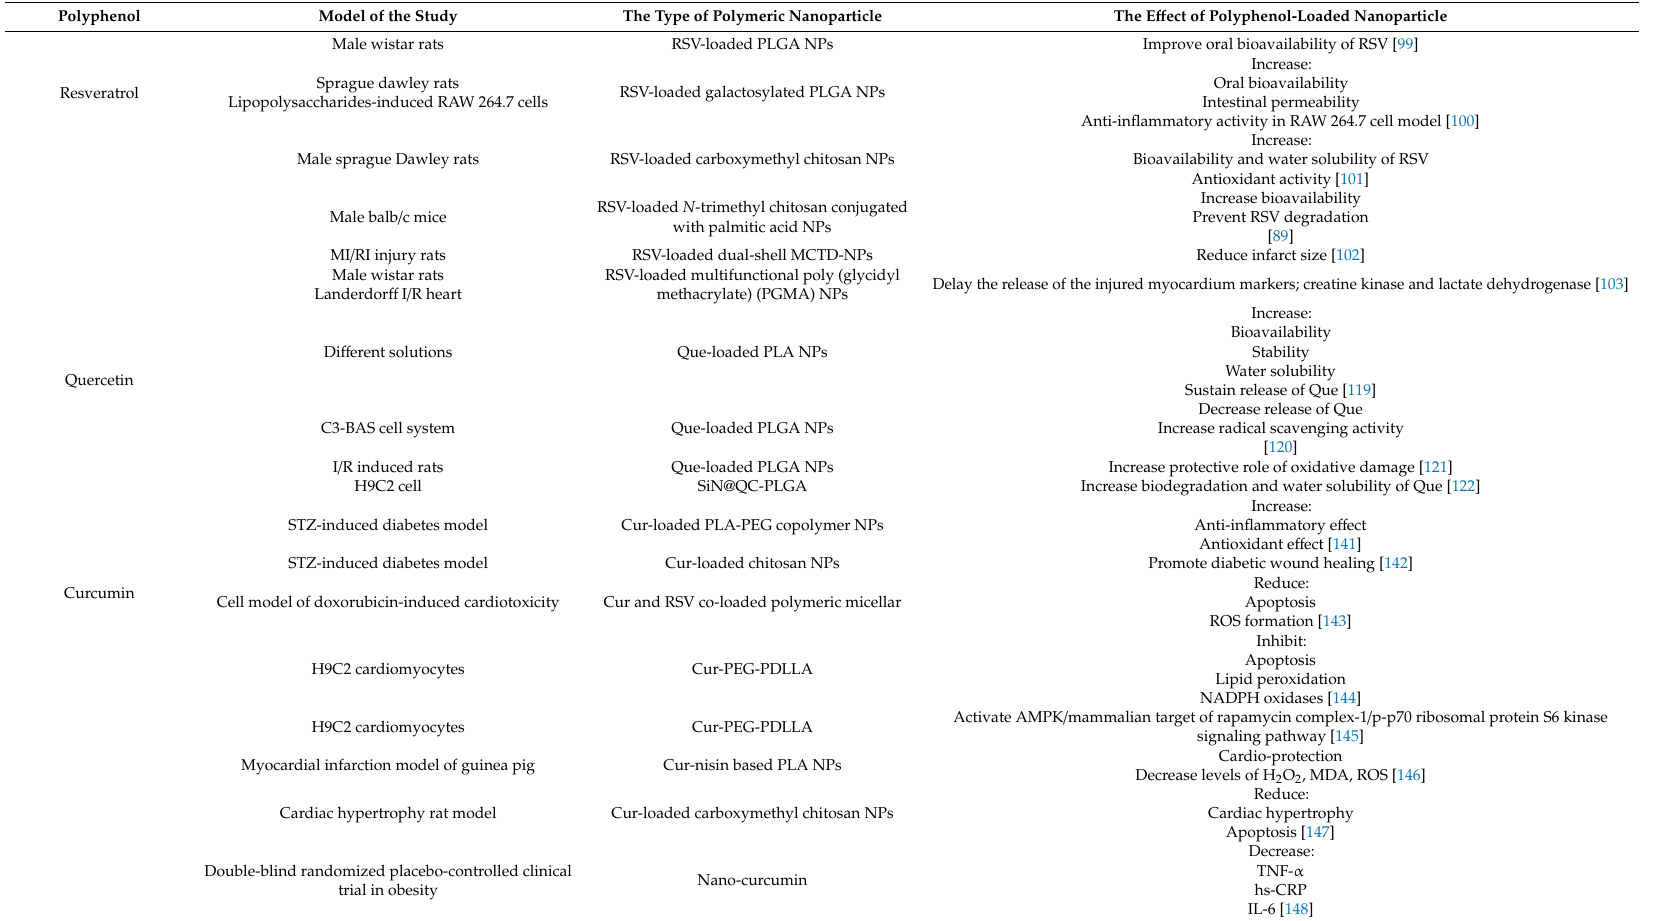
Table 1. An overview of polyphenol-loaded polymeric nanoparticles and their possible e ff